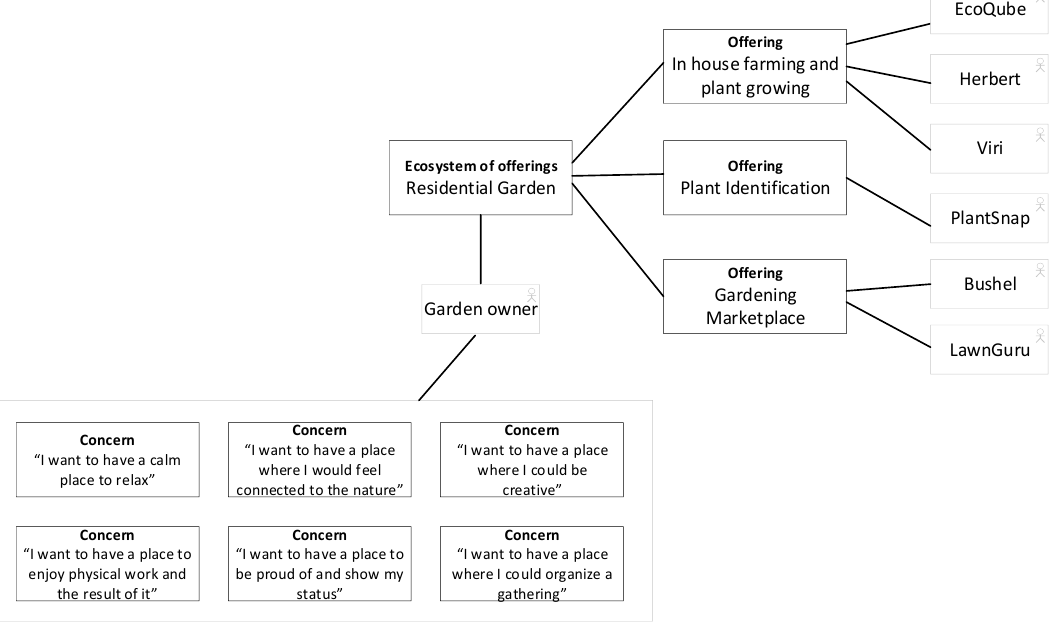
Figure 8. Residential garden ecosystem, offerings with the related actors and key concerns that are relevant for the garden owner (business actor)